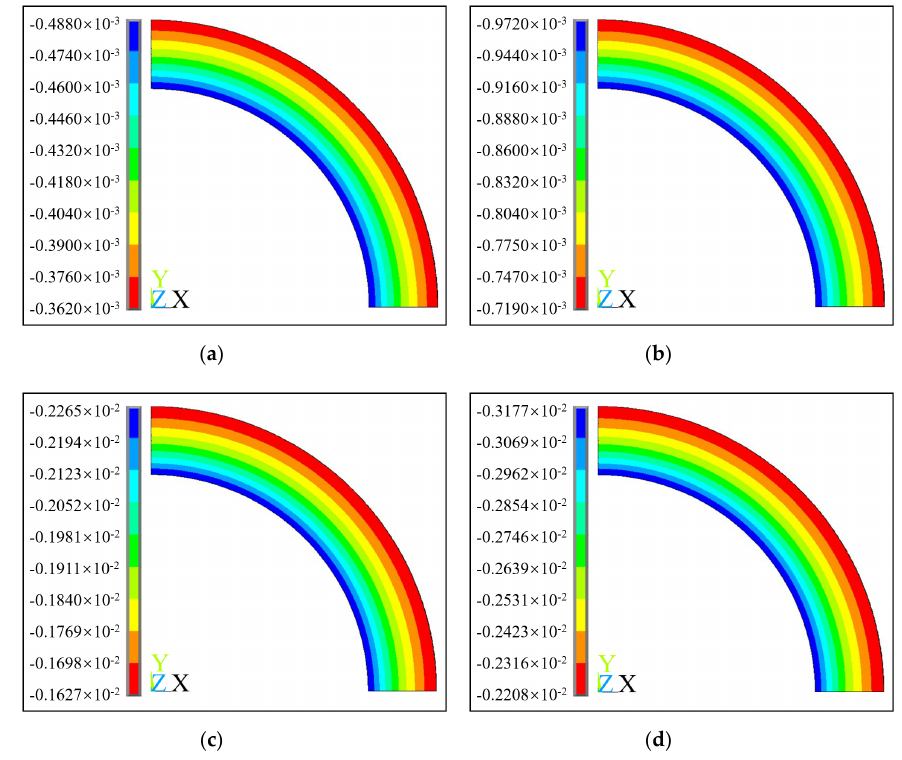
Figure 9. Hoop strain cloud diagrams of D-8 model shaft lining concrete under a surface load: ( a ) 5 MPa; ( b ) 10 MPa; ( c ) 19 MPa; ( d ) 25.3 MPa.